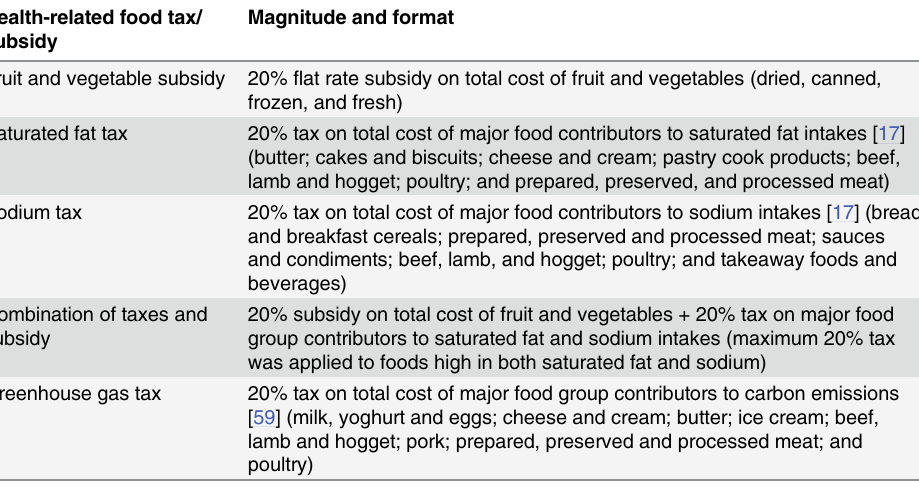
Table 1. Health-related taxation and subsidy regimens